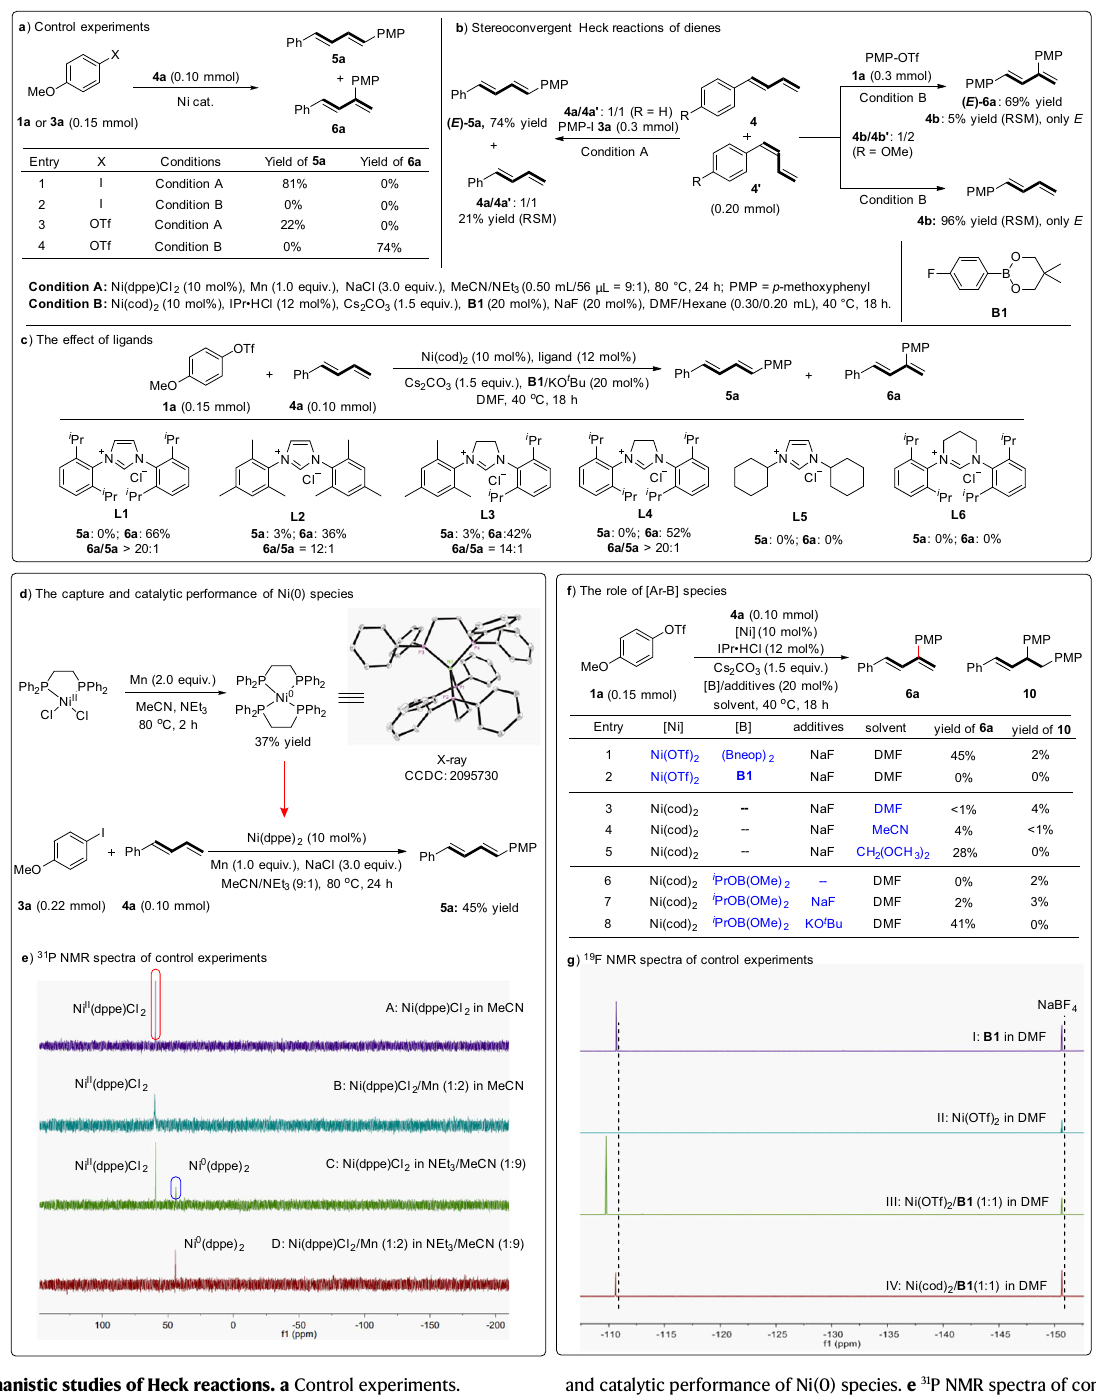
and catalytic performance of Ni(0) species. e 31 P NMR spectra of control